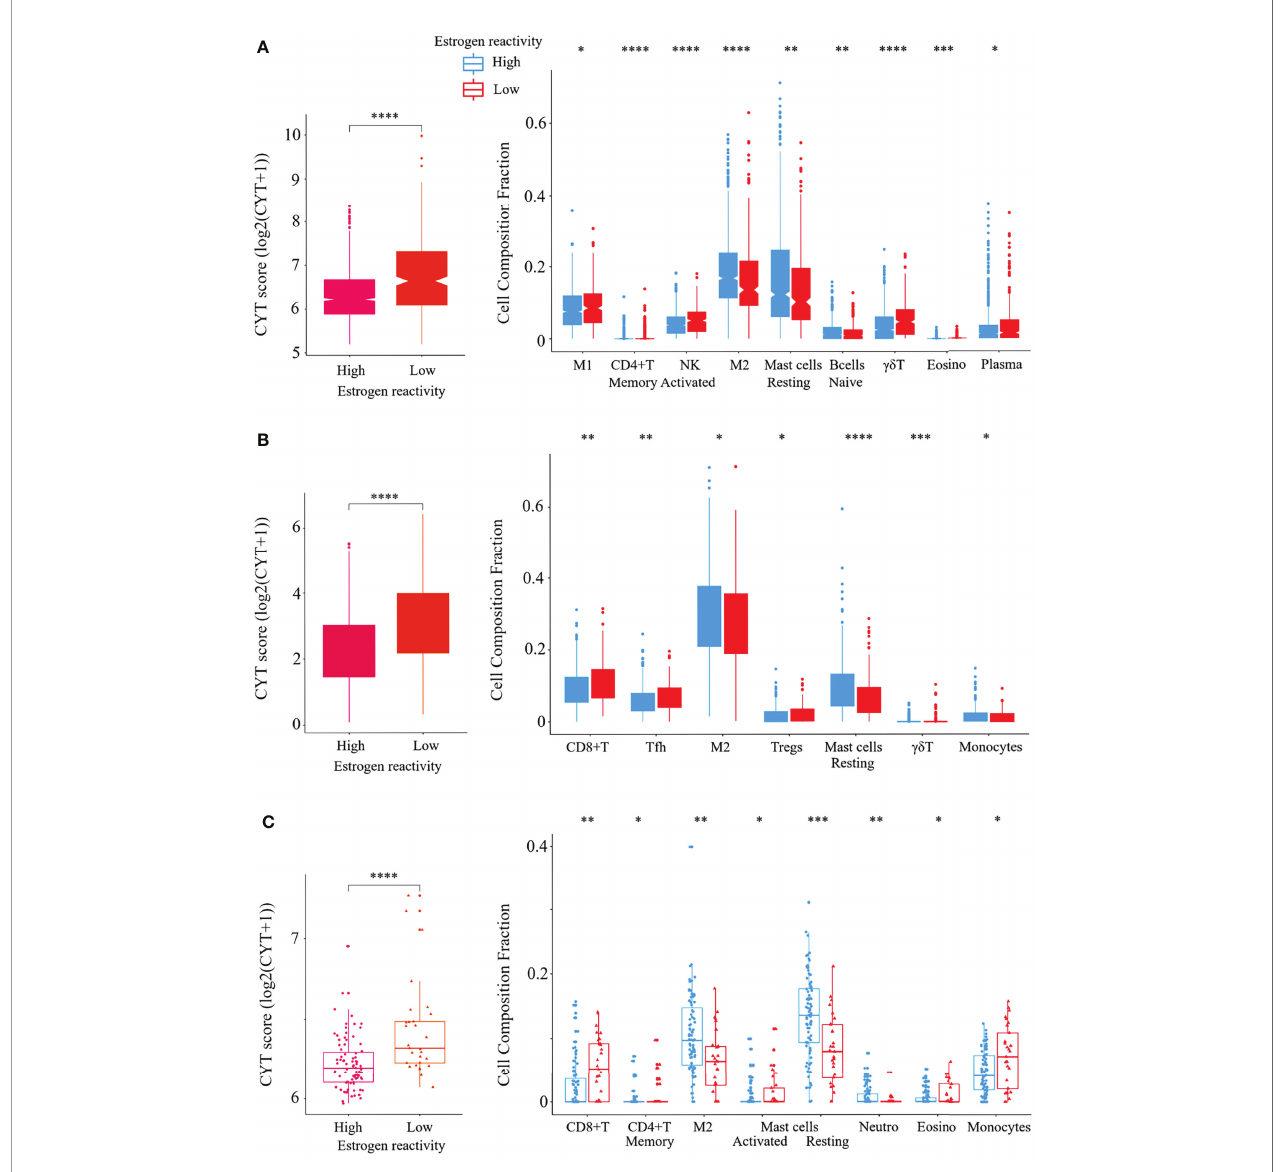
FIGURE 3 | Veri fi cation of the relationship between estrogen reactivity and CYT and immune cell fractions. Box plots of the relationship between estrogen reactivity and CYT; left panel and immune cell fractions; right panel in METABRIC (A) and TCGA (B) and our cohort (C) were shown. **** means P < 0.0001, *** means P < 0.001, ** means P < 0.01, and * means P < 0.05. CYT, immune cytolytic activity; METABRIC, Molecular Taxonomy of Breast Cancer International Consortium; TCGA, The Cancer Genome Atlas; M1, M1 macrophage; NK, activated NK cells; M2, M2 macrophage; Tfh, follicular helper cells; Tregs, CD4+ regulatory T